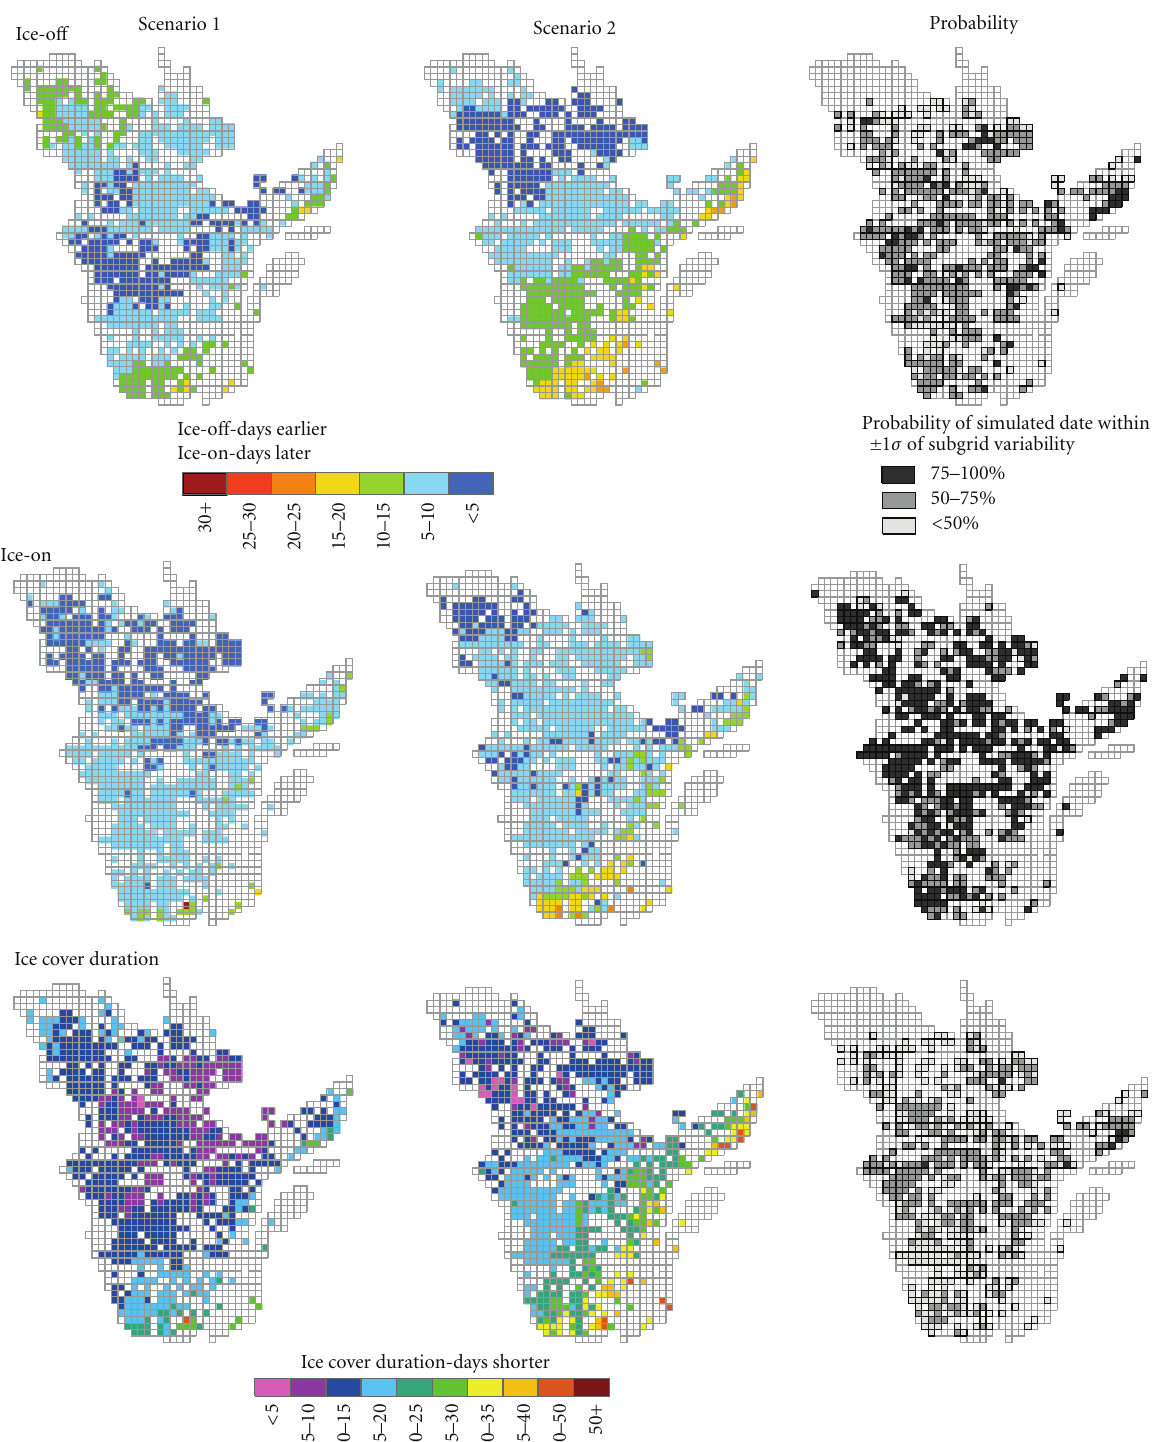
Figure 11: Ice-on, ice-o ff , and ice cover duration (ICD) changes from the 1981–2010 mean to the 2041–2070 mean for both future climate scenarios, with the probability of the model simulating within ± 1 standard deviation of the sub-grid cell variability (from Figure 10) indicated. Grid cells are 32km resolution similar to the previous